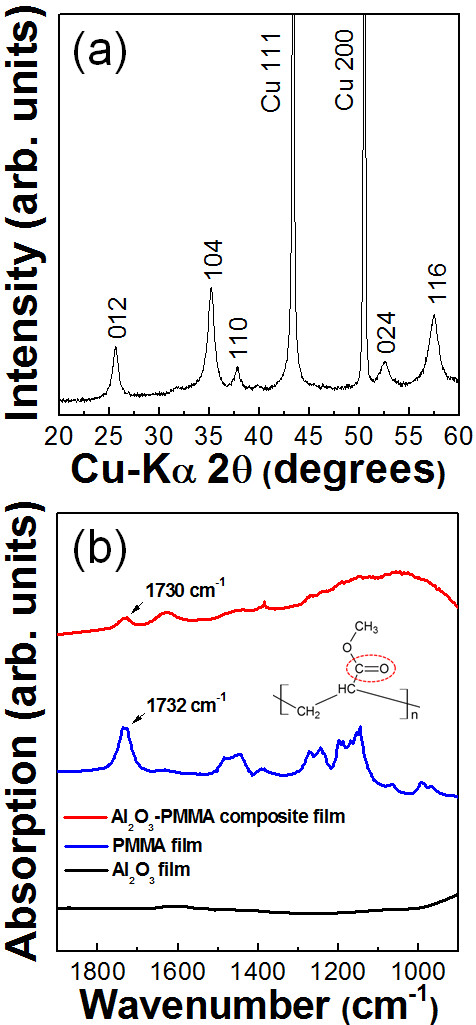
XRD patterns and and FT-IR spectra. (a) XRD patterns of the Al2O3-PMMA (15 vol.%) composite films. (b) FT-IR spectra of the Al2O3-PMMA (15 vol.%) composite, PMMA, and Al2O3 films.